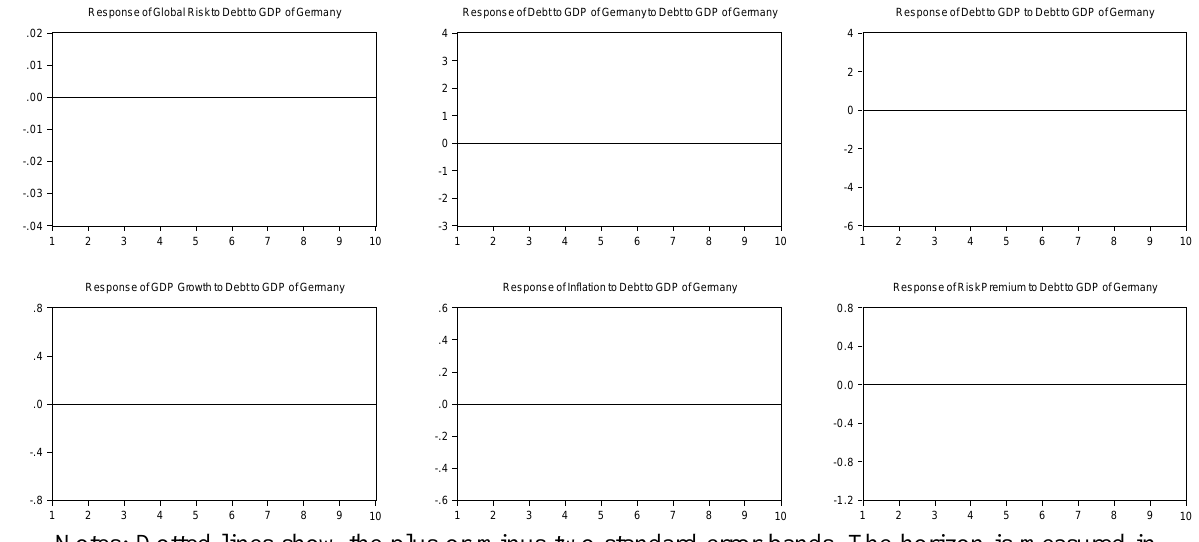
Figure 19. Response of EMU countries to a shock to Germany’s debt-to-GDP ratio during the crisis: